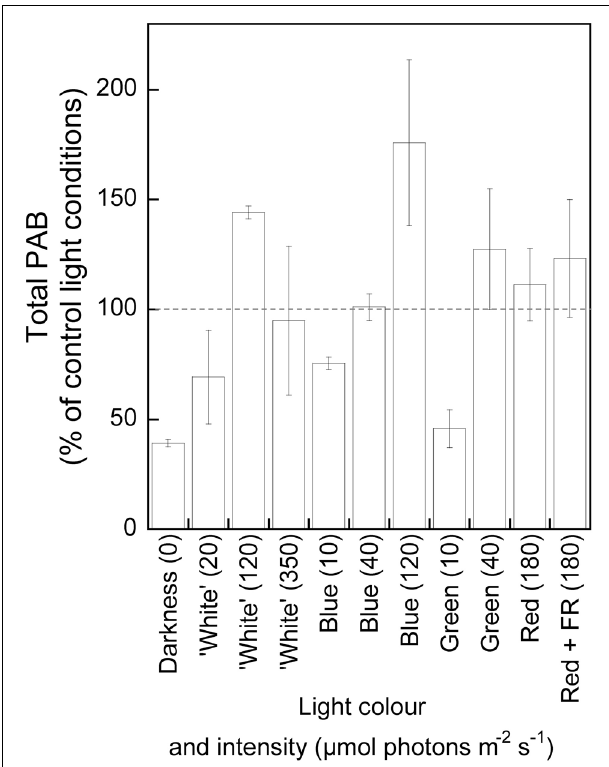
FIGURE 5 | Microphytobenthos total photosynthetically active biomass (PAB in% of the control light conditions) at the surface of muddy sediment and under different light exposures of 24 h. Values are the mean ± SD of n measurements for each light condition. The light conditions were as follows: darkness (0 µ mol photons m − 2 s − 1 , n = 2), “white” light (emission maxima at 459 and 553 nm, 20 µ mol photons m − 2 s − 1 , n = 2; 120 µ mol photons m − 2 s − 1 , n = 2; 350 µ mol photons m − 2 s − 1 , n = 2), blue light (465 nm, 10 µ mol